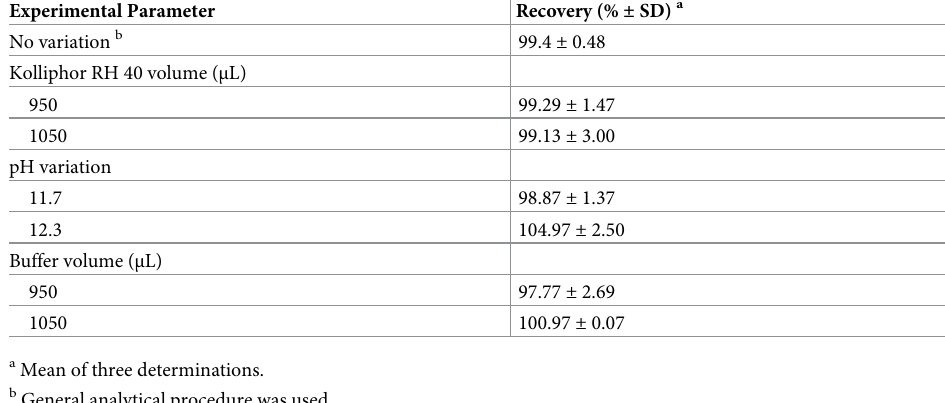
Table 5. Robustness of the proposed micellar-enhanced spectrofluorimetric method for determination of LAP. Experimental Parameter